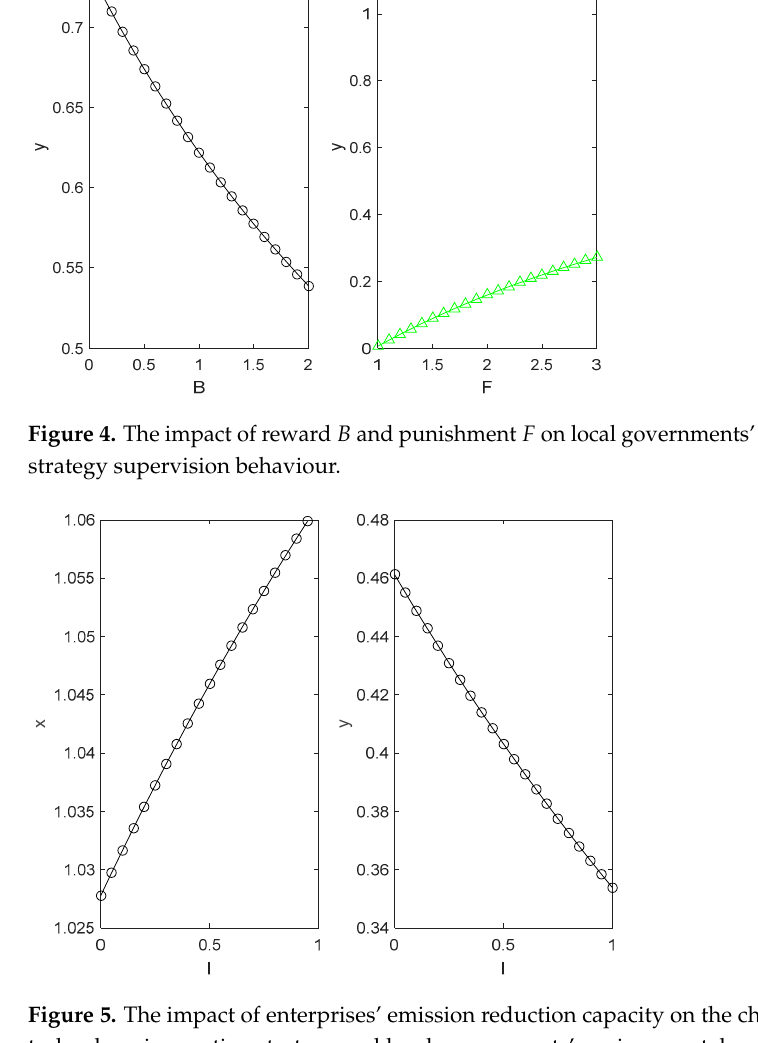
Figure 5. The impact of enterprises’ emission reduction capacity on the choice of enterprises’ green technology innovation strategy and local governments’ environmental regulation strategy.